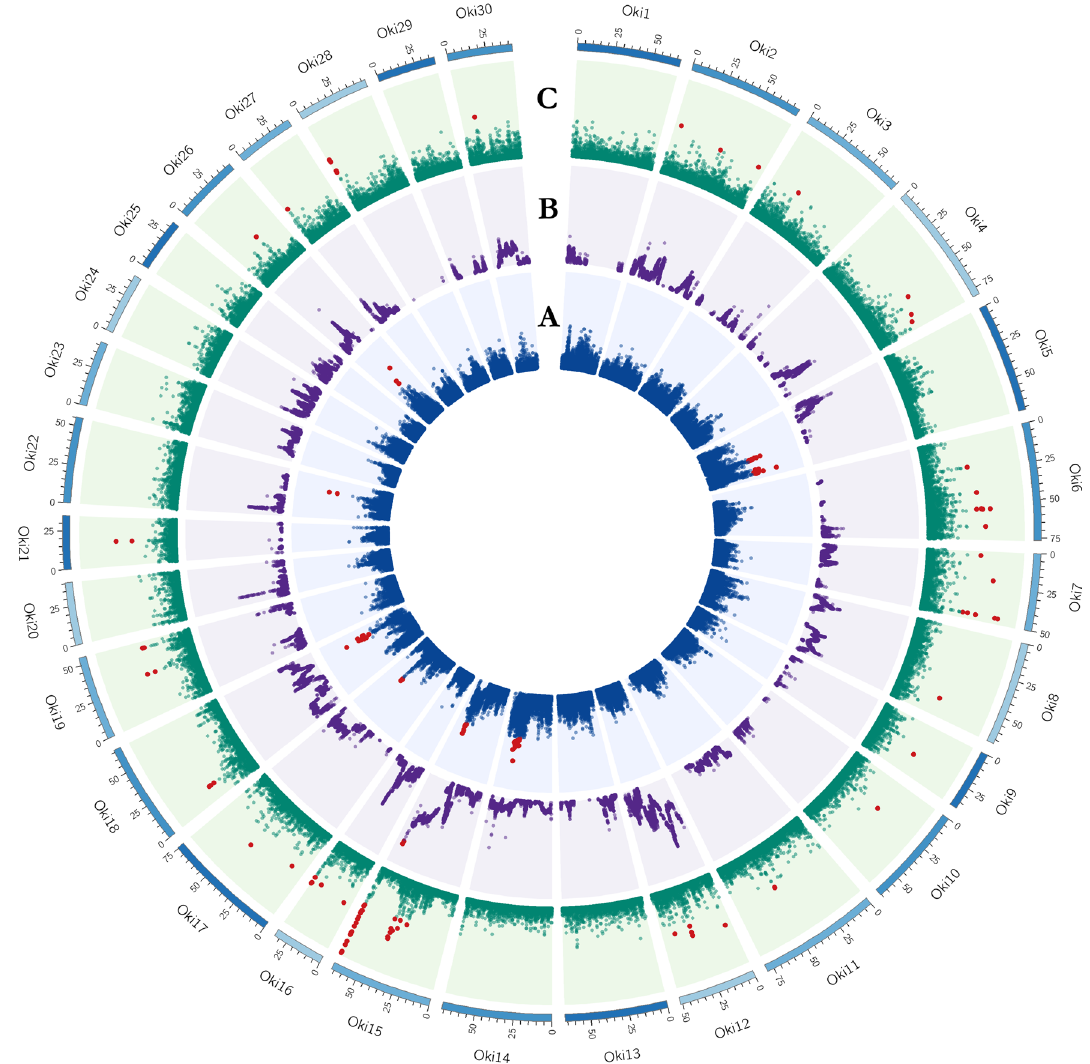
Figure 5. Circos plot of the global distribution of selection signatures across the genome in Pop-B. The circles from inside to outside illustrate: ( A ) −log 10 ( p value) of iHS (Blue); ( B ) −log 10 ( p value) of XP-EHH (Purple) and ( C ) CLR values (Green). Values for each test surpassing the threshold (iHS and XP-EHH ≥ 3, and CLR ≥ 4.64) are highlighted in